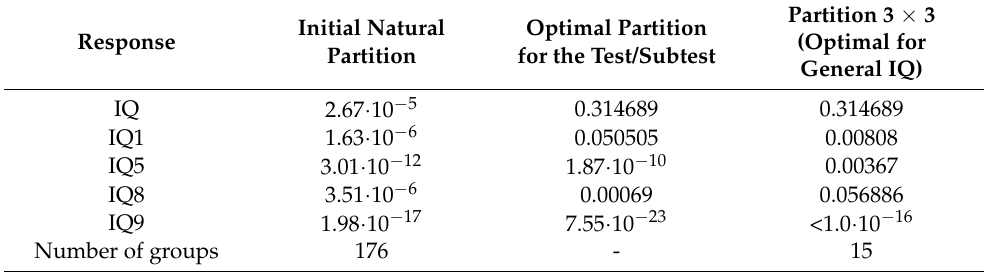
Table 5. P-values for Levene’s Test for Homogeneity of Variance (center = median).